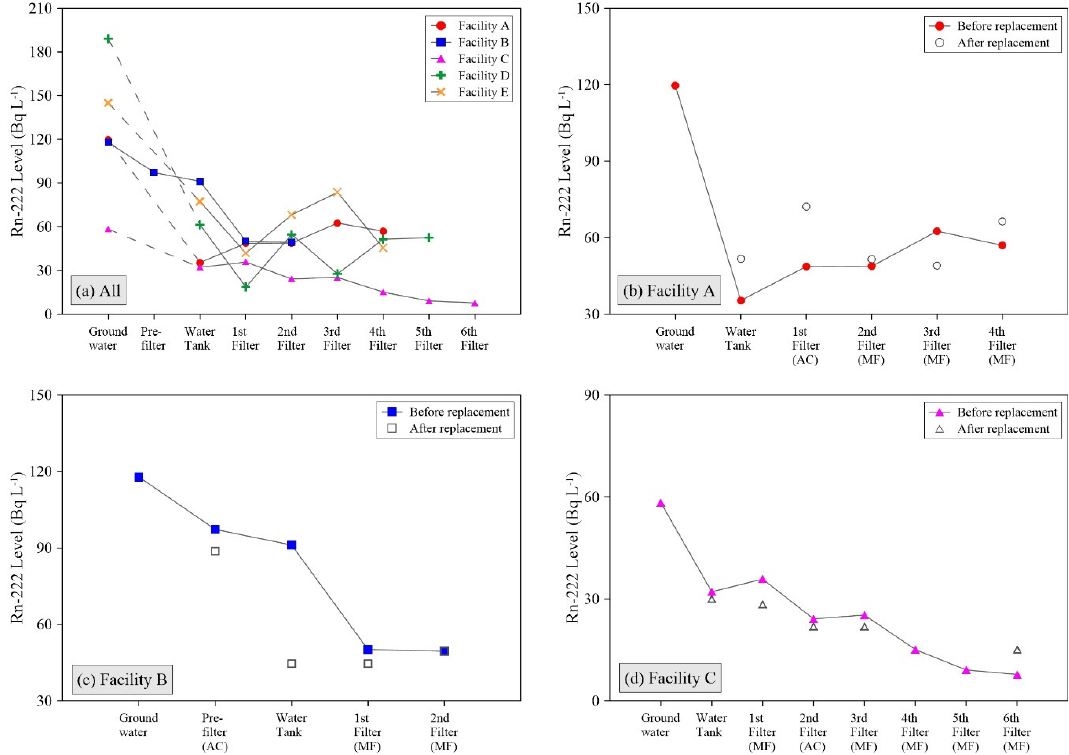
Figure 1. Changes in Rn-222 levels through the water treatment processes: ( a ) All facilities, ( b ) Facility A, ( c ) Facility B, and ( d ) Facility C. The dashed lines in the upper left figure indicate no filters or equipment in the relevant facilities.